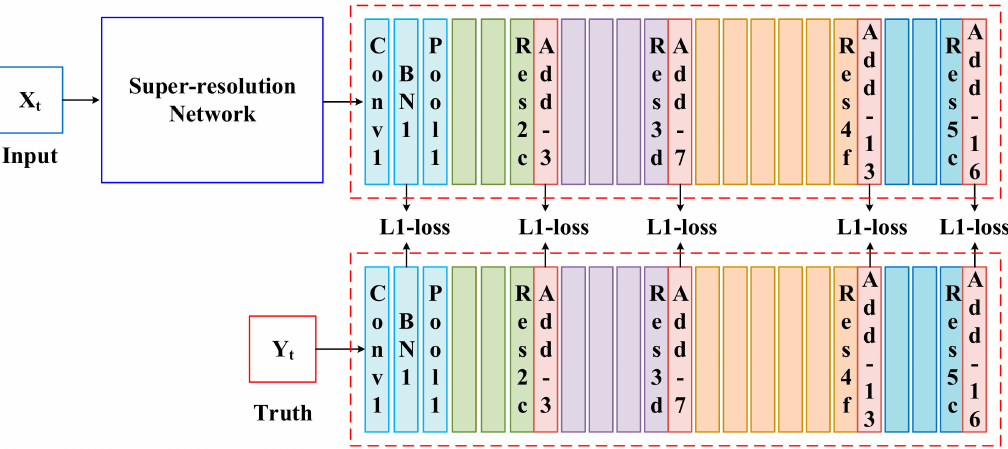
Figure 10. Schematic diagram of perceptual losses. The stacked multi-layer network in the red dashed box is the ResNet50 pretrained on ImageNet. We selected BN1, Add-3, Add-7, Add-13 and Add-16 as the perception